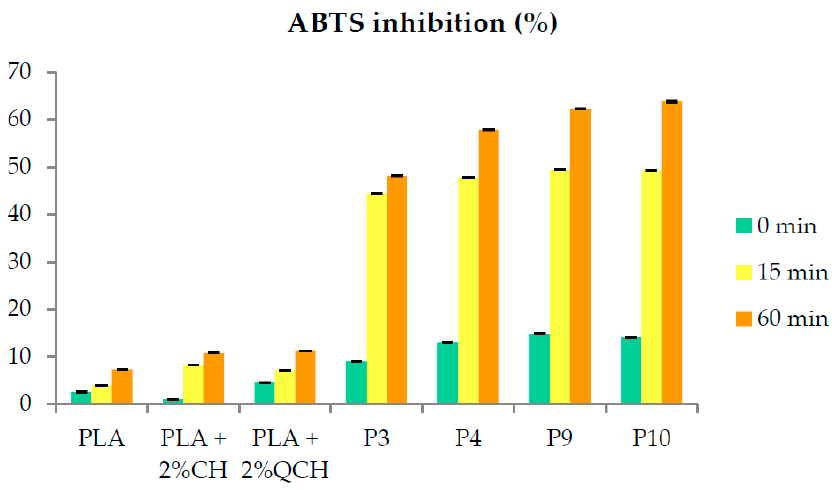
Figure 9. ABTS i nhibition after 0, 15, and 60 min for all films. Figure 9. ABTS inhibition after 0, 15, and 60 min for all